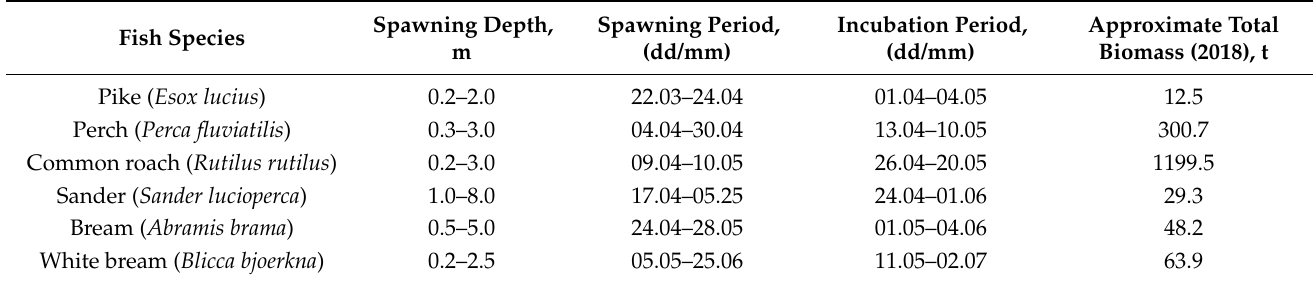
Table 1. The most common types of fish in the Kaunas HPP reservoir and their spawning information